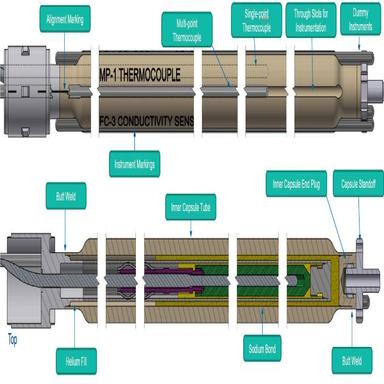
Shows a cross-section view of the IMPACT inner-capsule assembly (with the sodium-bonded rodlet shown).